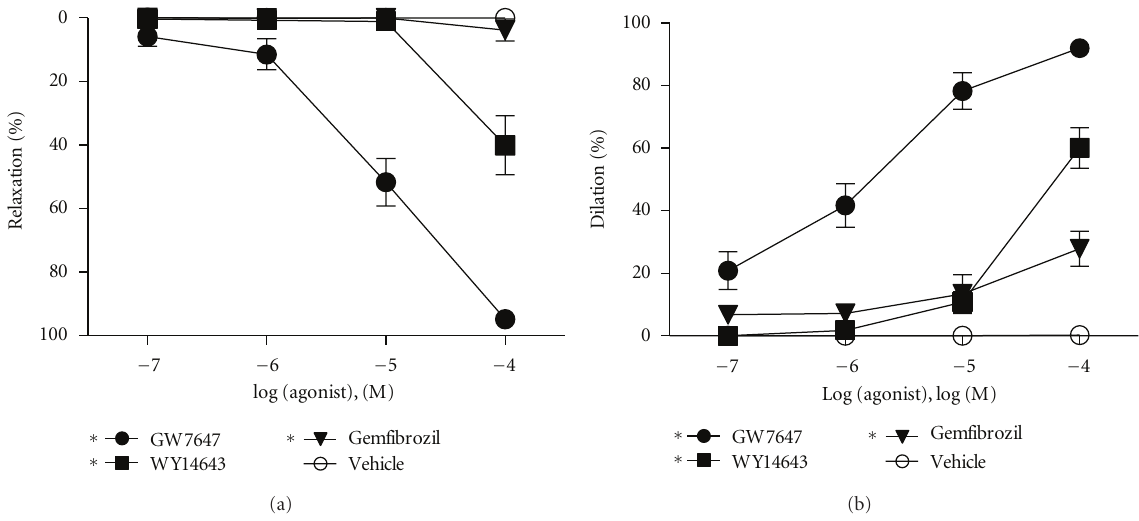
Figure 1: Response to PPAR α agonists in aortas and MCAs of WT mice. Concentration-response curves to three di ff erent PPAR α agonists (gemfibrozil, WY14643, and GW7647) in (a) mouse aortic rings precontracted with 10 − 5 M PGF 2 α by using isometric tension myography and (b) MCAs preconstricted with 10 − 5 M PE by using isobaric myography. All three PPAR α agonists relaxed aortic rings ( n = 3–5) as well as dilated the MCA ( n = 7). Data are means ± SEM. ∗ Indicates P ≤